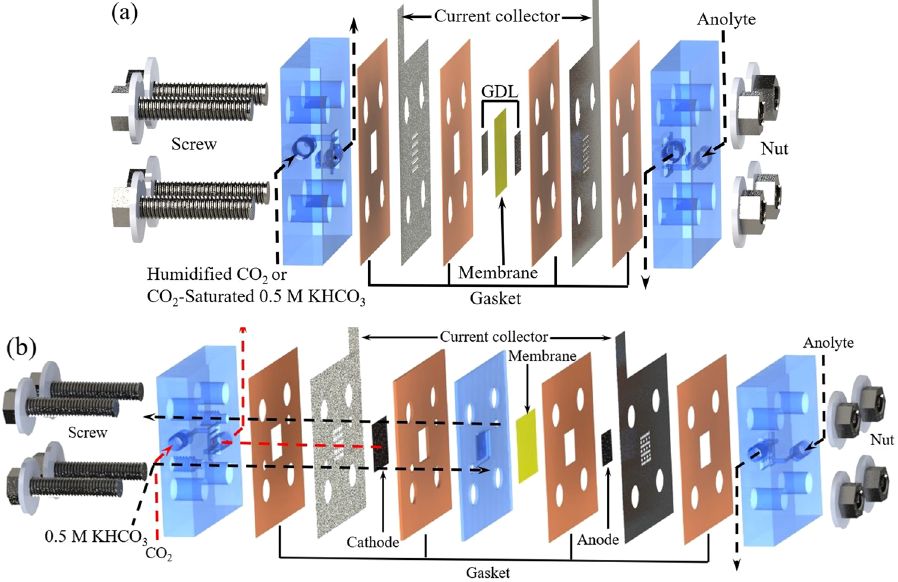
Figure 1. Expanded view of the CO 2 electrolysers: (a) zero-gap MEA configuration, (b) with a liquid buffer layer at the cathode